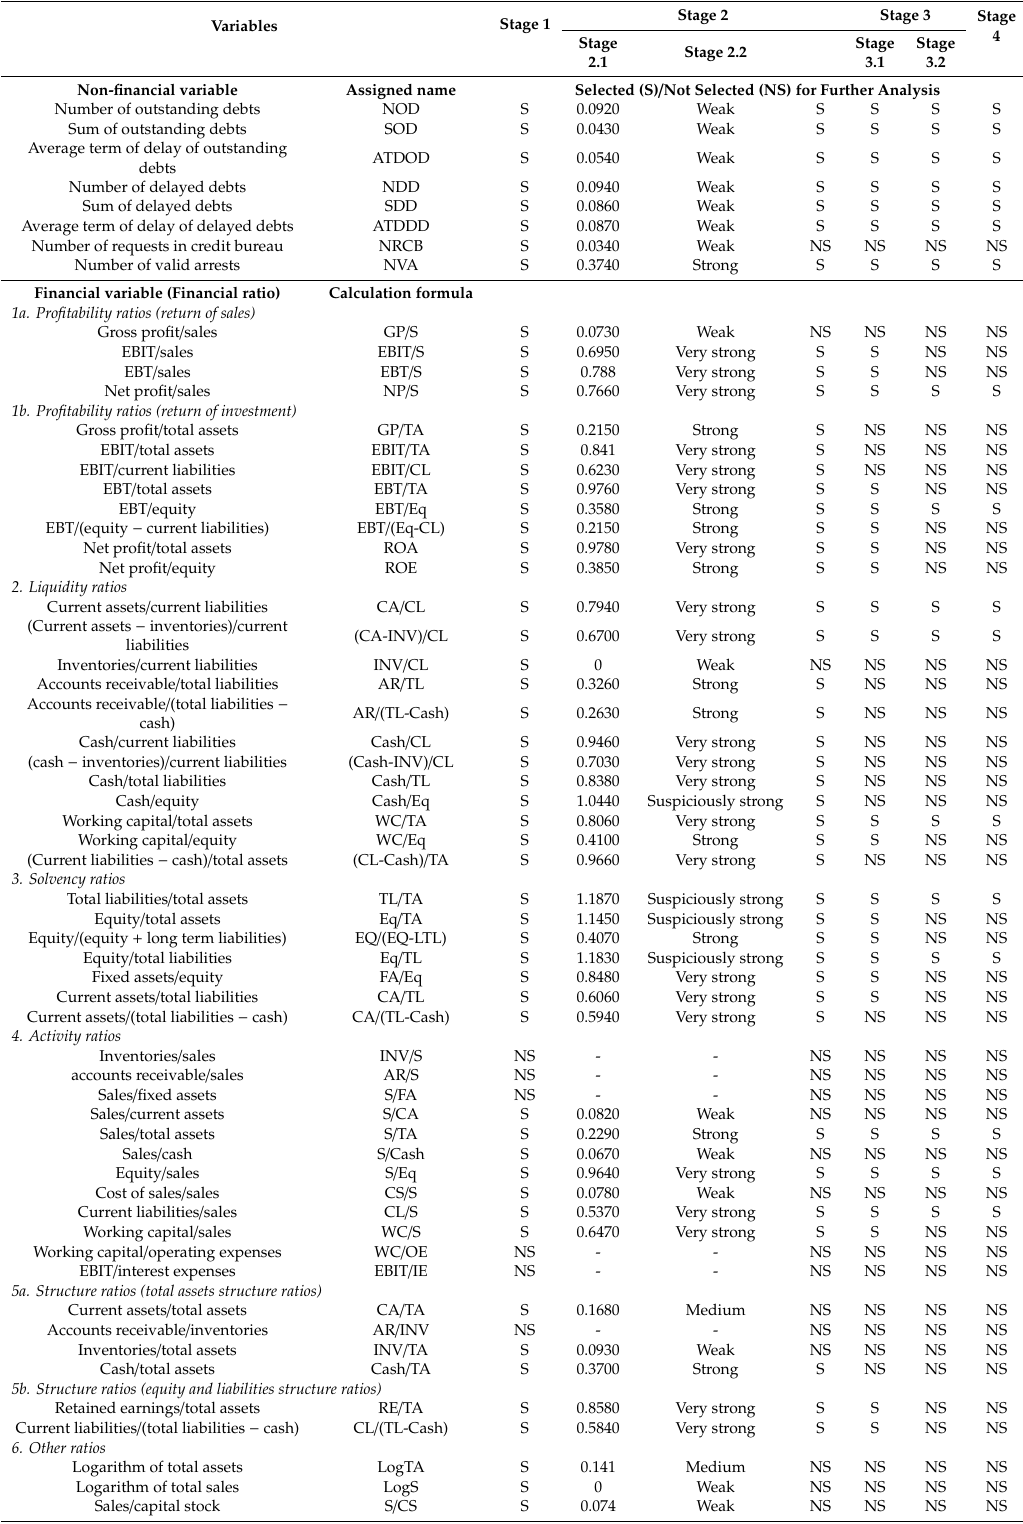
Table A4. Inclusion of variables into logistic regression model for